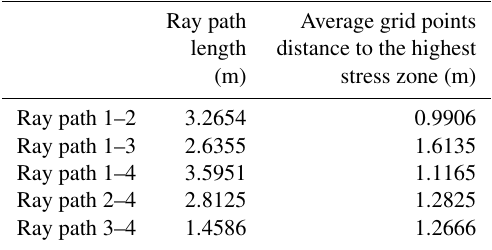
Table 3. Information of ray paths surrounding ONK-EH3 at the depth of